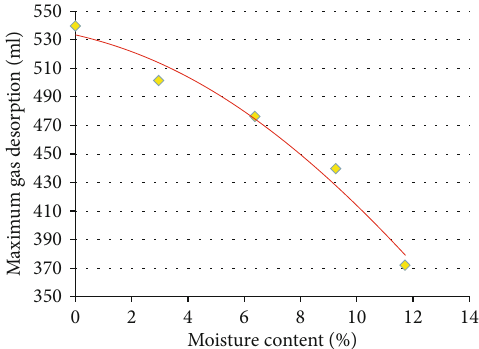
Figure 8: Maximum gas adsorption amounts of the coal bodies with di ff erent water content